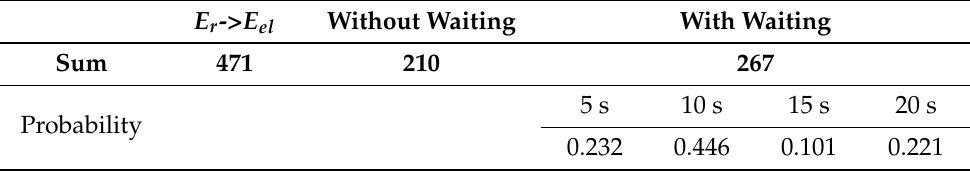
Table 6. Statistics of the users’ waiting event on elevator based on the mapping result of FSMs.